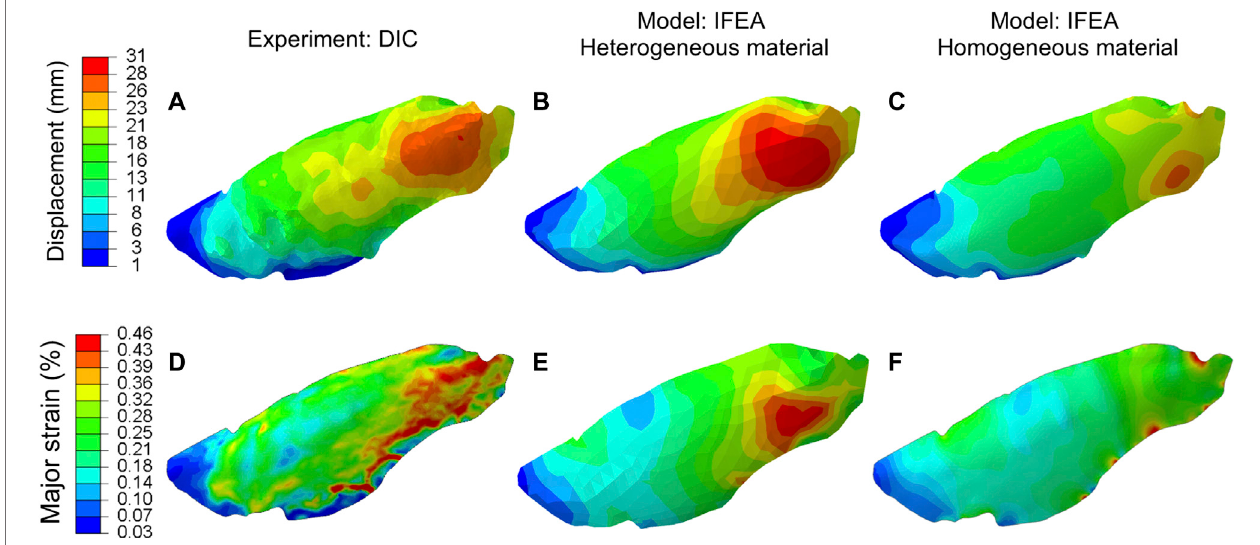
FIGURE 5 | Comparison between the displacement (A – C) and major strain (D – F) of the DIC and IFEA with either homogeneous and heterogeneous material models. The computed displacement and strain contours of the heterogeneous model agreed with the DIC data better than the homogeneous model. The heterogeneous model results are based on the SQP algorithm, and the PSO algorithm yielded similar results.